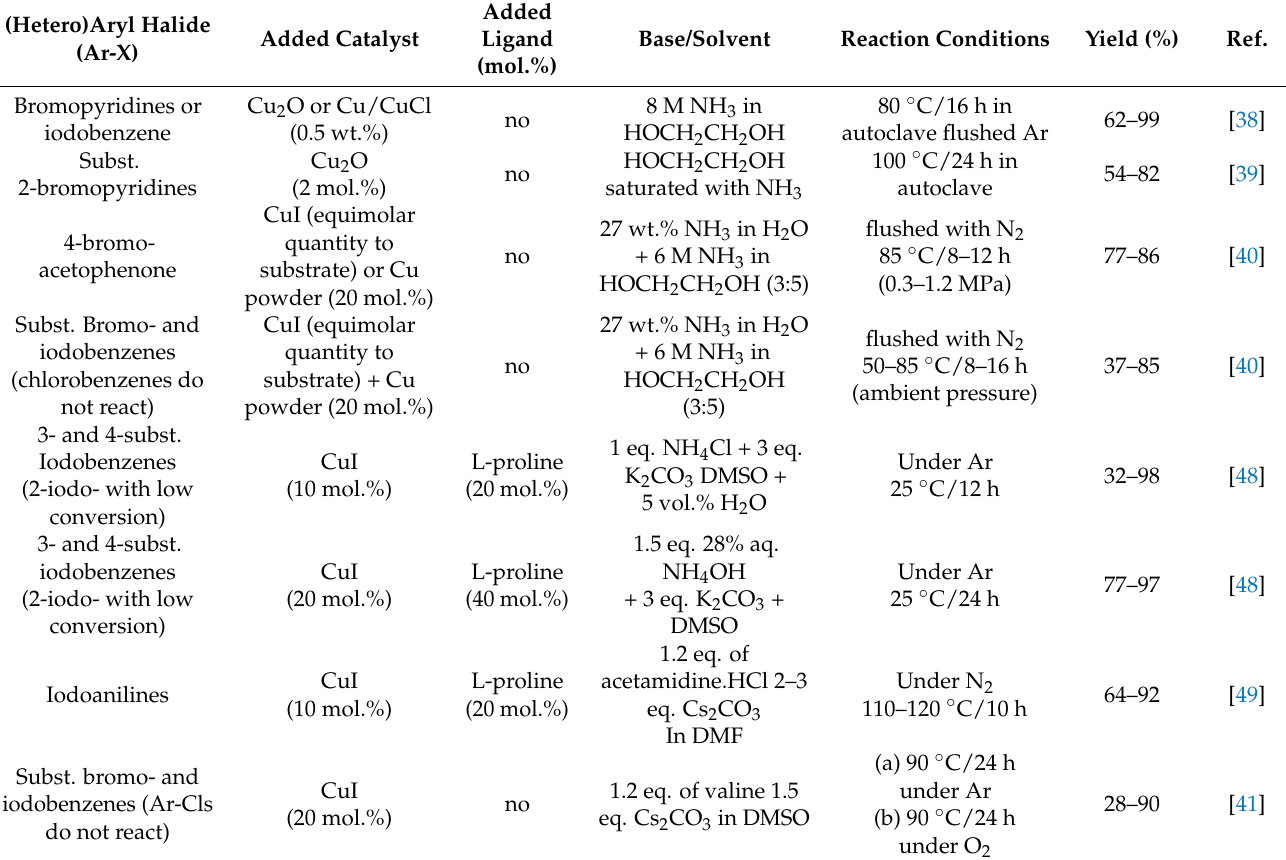
Table 1. Cu-catalyzed amination of (hetero)aryl halides using NH 3 , NH 4 Cl, acetamidine or